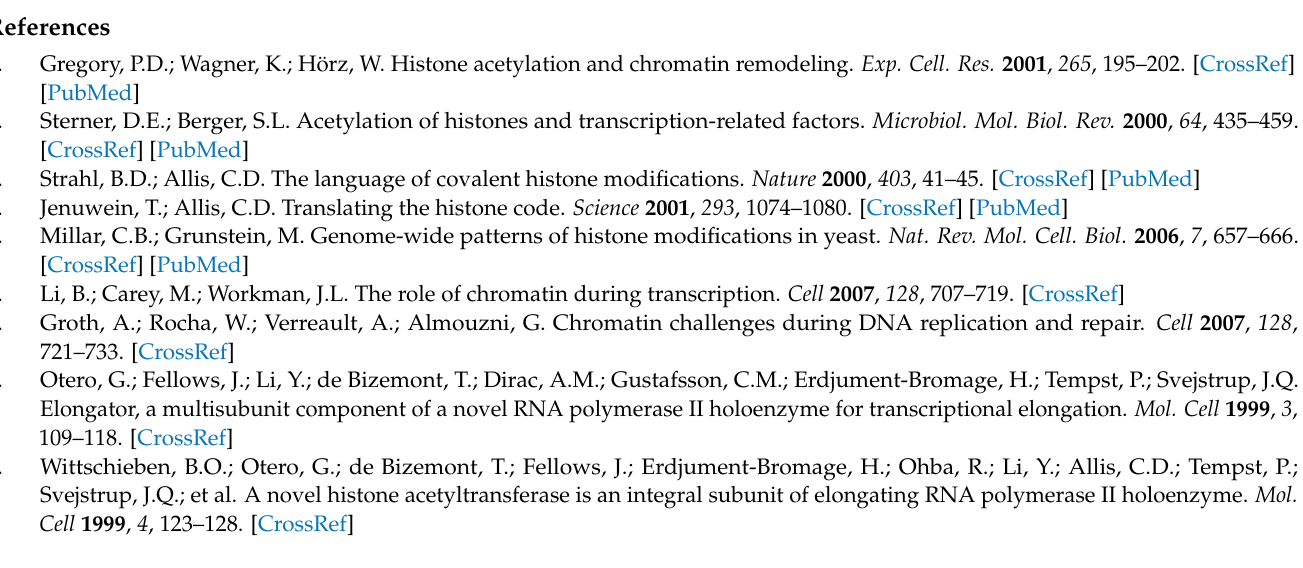
of BbElp3 deletion on carbon/nitrogen metabolism; Table S1: Primers used for genetic manipulation of Elp3 in B. bassiana ; Table S2: Lists of 775 differentially expressed genes in ∆ BbElp3 versus WT; Table S3: The RPKMs of the 775 DEGs in the heatmap of ∆ BbElp3 versus WT; Table S4: Lists of 62 Elp3-regulated genes involved in DNA events, cell cycle, and transcription of B. bassiana ; Table S5: Lists of 58 Elp3-regulated genes involved in cellular transportation of B. bassiana ; Table S6: Lists of 28 Elp3-regulated genes involved in cell communication and morphogenesis of B. bassiana ; Table S7: Lists of 89 Elp3-regulated genes involved in cell rescue, defense, and virulence of B. bassiana ; Table S8: Lists of 80 BbElp3-regulated genes enriched in pathogen-host interaction (PHI) networks; Table S9: Lists of 64 DEGs enriched in 57 KEGG pathways in ∆ BbElp3 versus WT; Table S10: Lists of the top 20 upregulated genes and the top 20 downregulated genes in ∆ BbElp3 versus